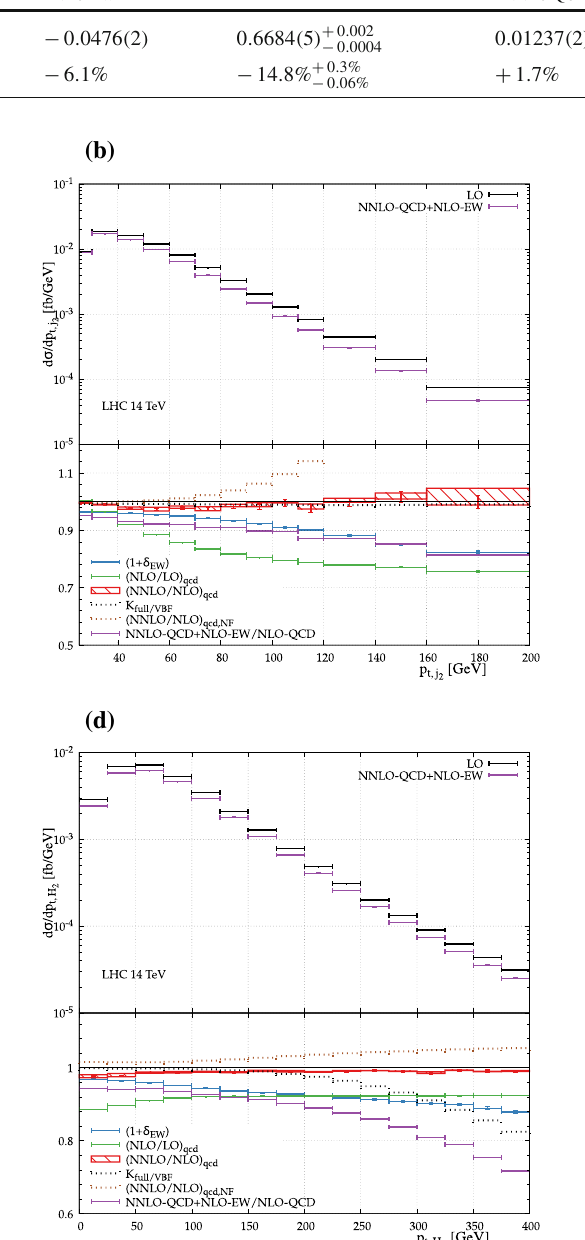
Fig. 2 Differential distributions for pp → jjHH at the LHC with centre-of-mass energy of 14 TeV: a transverse momentum of the hard- est jet (top left), b transverse momentum of the second hardest jet (top right), c transverse momentum of the hardest Higgs boson (bottom left), and d transverse momentum of the second hardest Higgs boson (bottom right).TheupperpanelshowstheabsolutecontributionsatNNLOQCD